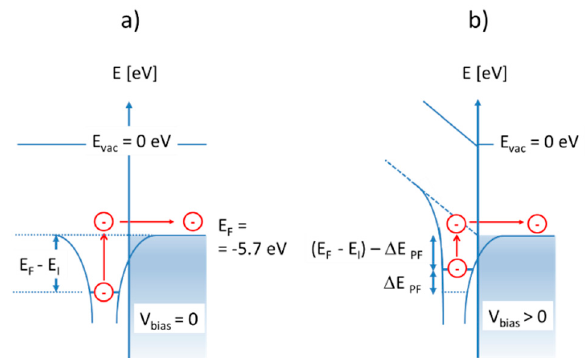
Figure 16. ( a ) Energetics of surface ionization under low-field conditions; ( b ) reduction of effective ionization energy under high-field conditions [40,41].